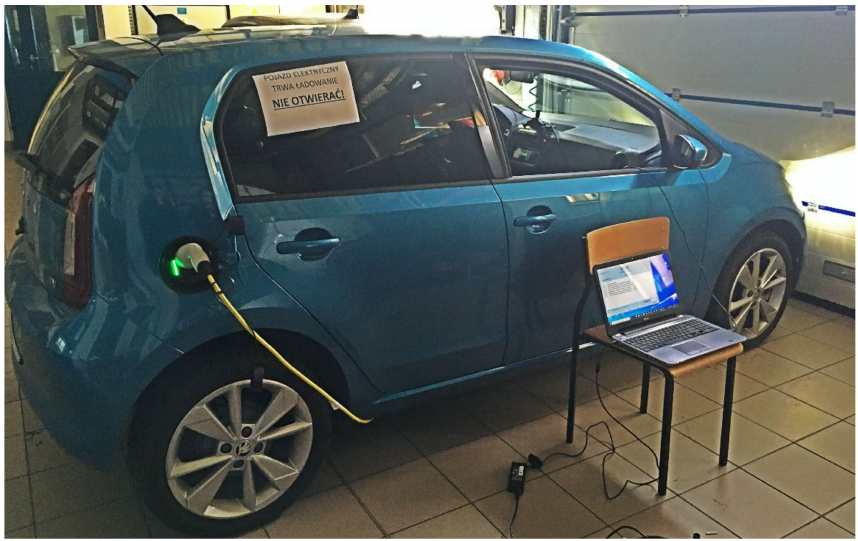
Figure 3. Vehicle charging setup.